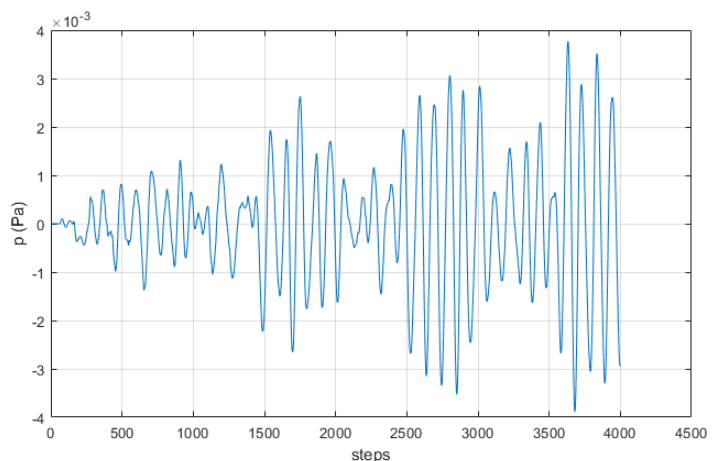
Figure 15. Pressure time history at the top end of the vertical beam.